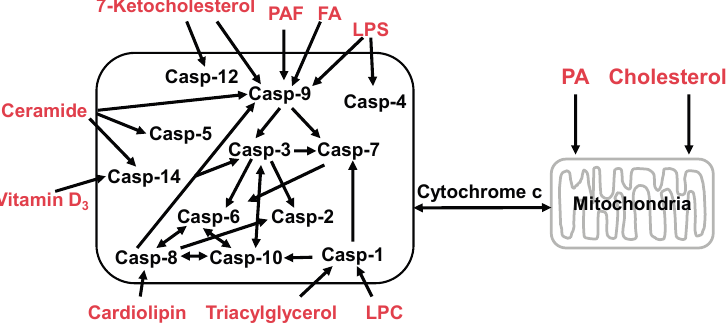
Figure 4. Lipids regulate apoptotic signaling in the cells. Phosphatidic acid